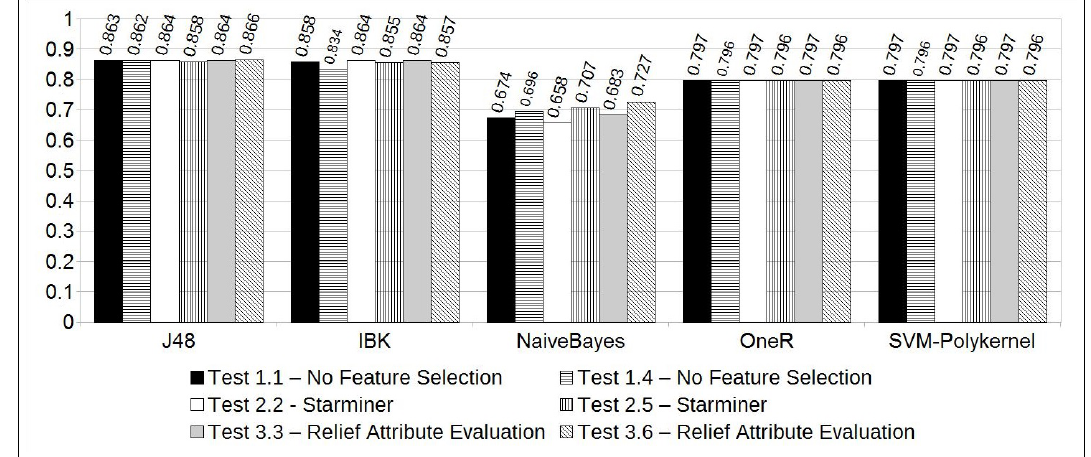
Figure 5. Accuracy.